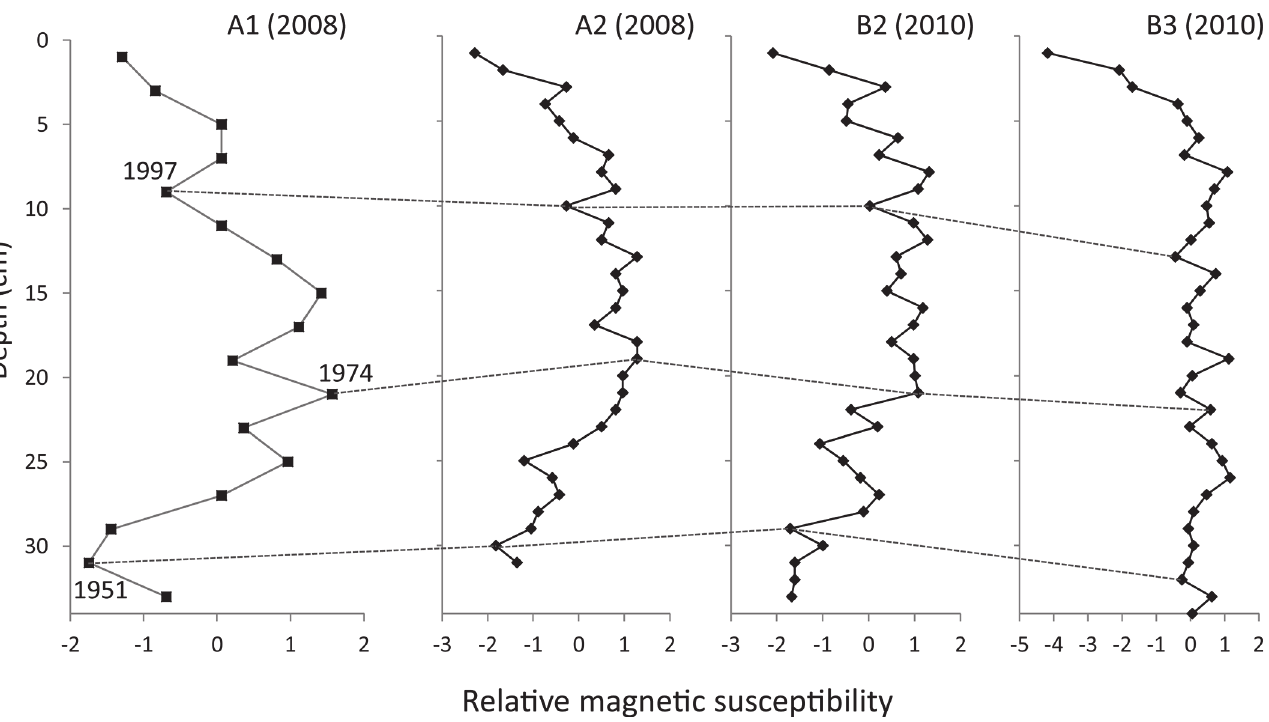
Fig 2. Profiles of magnetic susceptibilities in four cores of lake sediments from Lake Hataya Ohnuma. A peak and troughs of the magnetic susceptibilities in 1997 (6 – 7 cm), 1974 (20 – 21 cm) and 1951 (30 – 31 cm) in core A1 were used for developing chronologies of cores A2, B2 and B3. Sediment layers corresponded to the peak and toughs in core A1 are connected with dotted